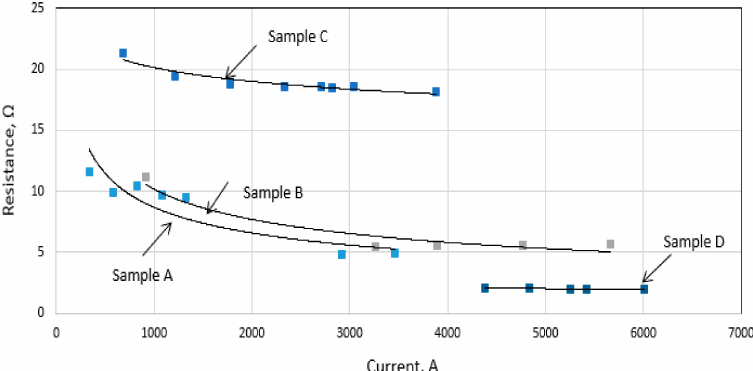
Figure 13. Impulse resistances for electrodes installed in different soil resistivity under positive impulse